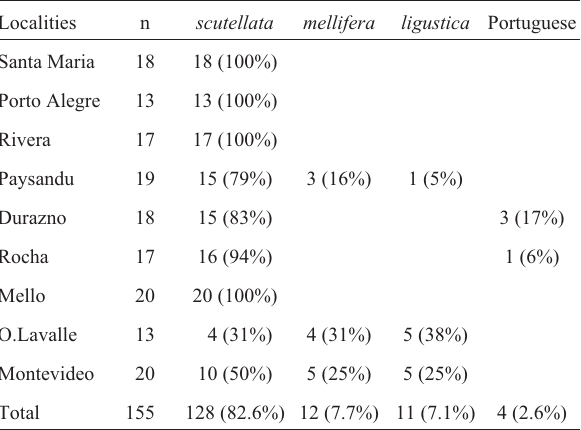
Table 1 - Distribution of mtDNA patterns ( scutellata, ligustica, mellifera or Portuguese haplotypes) in bee populations from southern Brazil and